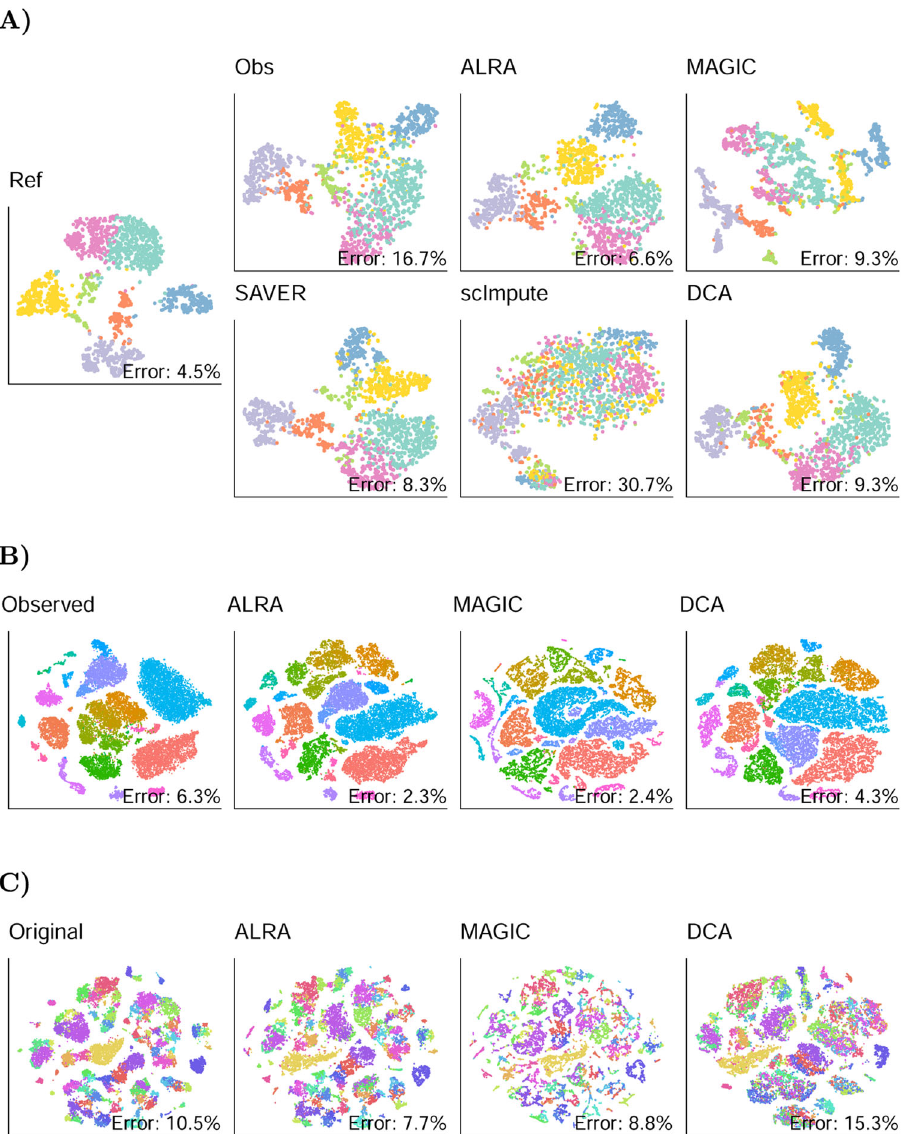
Fig. 3 ALRA improves separation of cell types. A t-SNE of mouse brain cells from Zeisel et al. were computed based on the original data (Ref). The reads were downsampled which introduced additional technical zeros and decreased the separation of different cell types (Obs). t-SNE after imputation by ALRA and other algorithms. To quantitatively compare separation of cell types, a random forest was trained to predict cell class based on expression values, and the out-of-bag classi fi cation error is shown in each plot. B The effect of imputation on separation of previously annotated cell types in mouse visual cortical cells from Hrvatin et al. and in mouse neocortical cells ( C ) from Tasic et al. Unlike in ( A ), the datasets were not downsampled prior to imputation as they already had high dropout